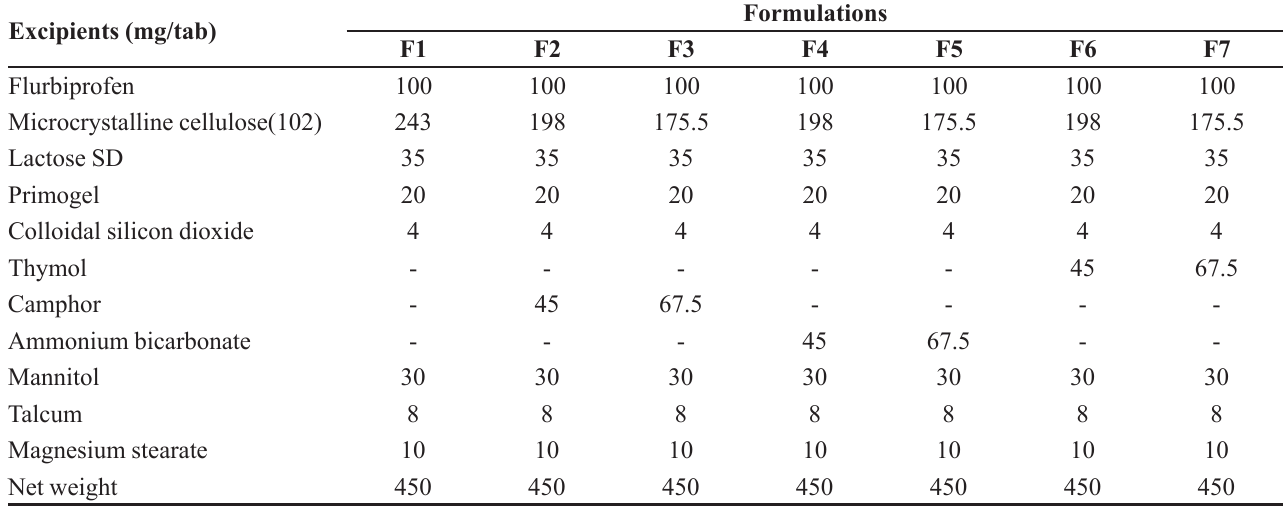
TABLE I - Composition of formulations prepared by sublimation technique Excipients